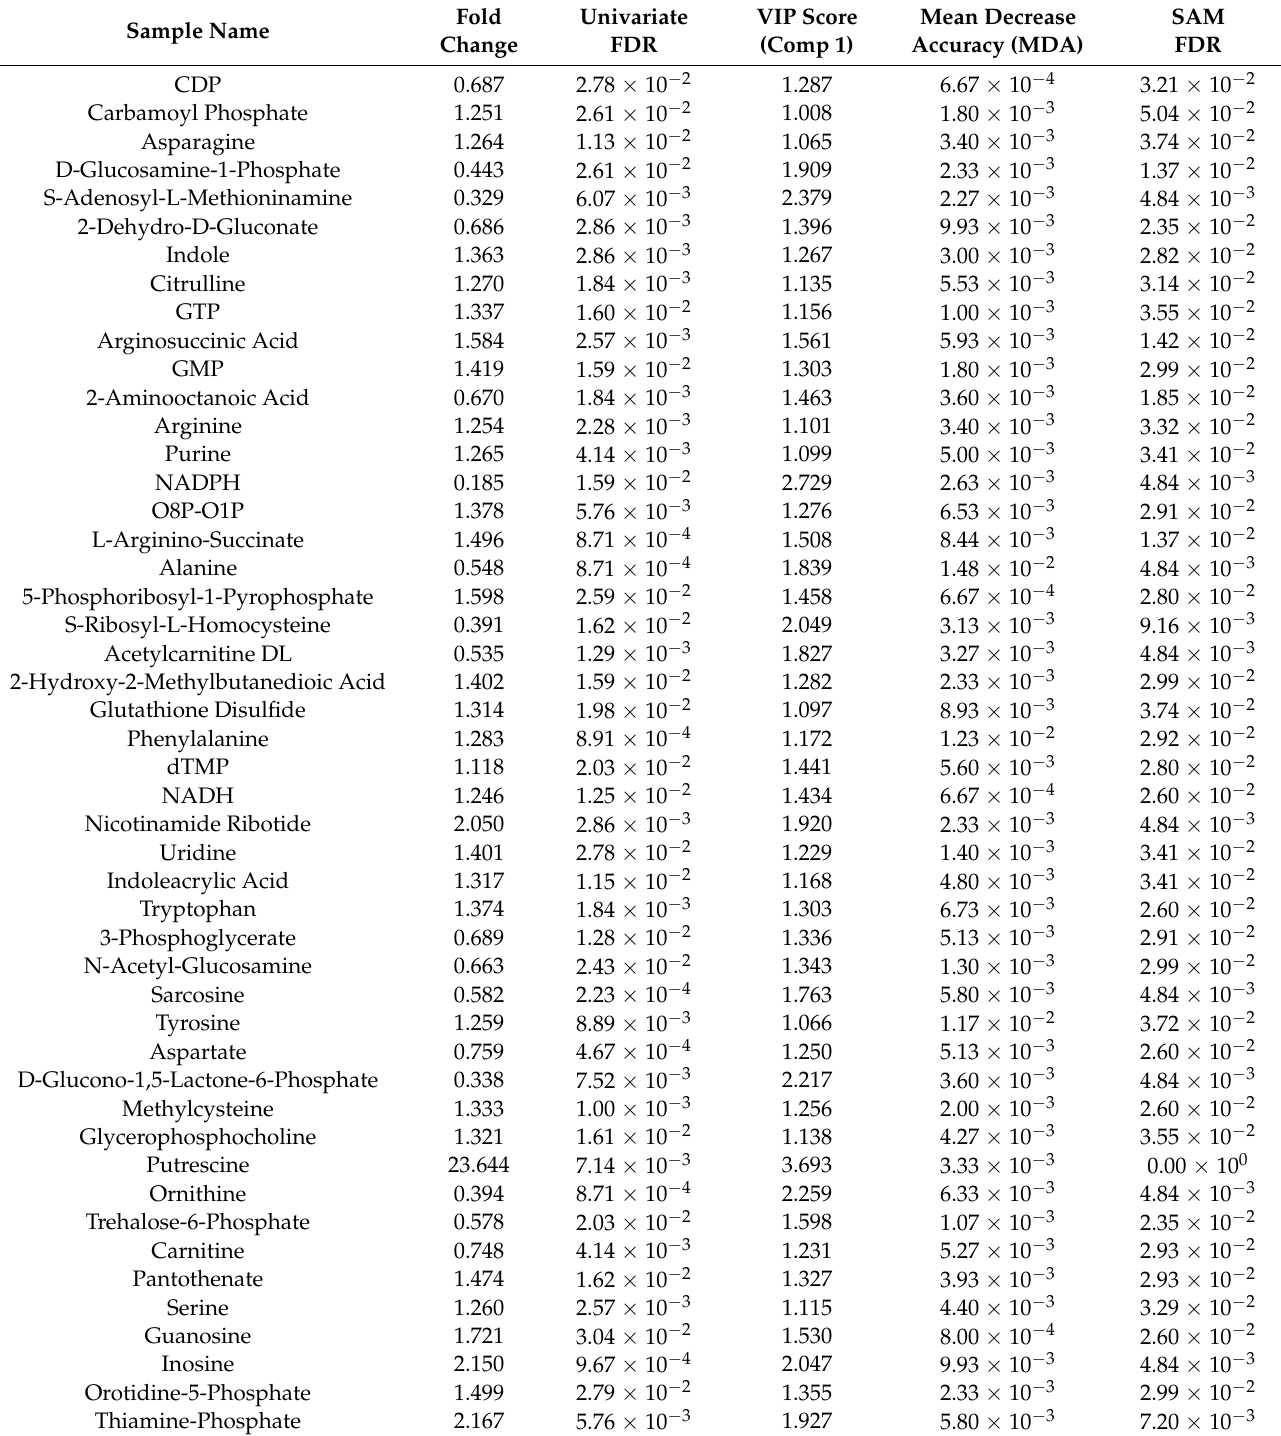
Table 2. Discriminant metabolites identified after induction of Mfn2. Test statistics calculated for significantly